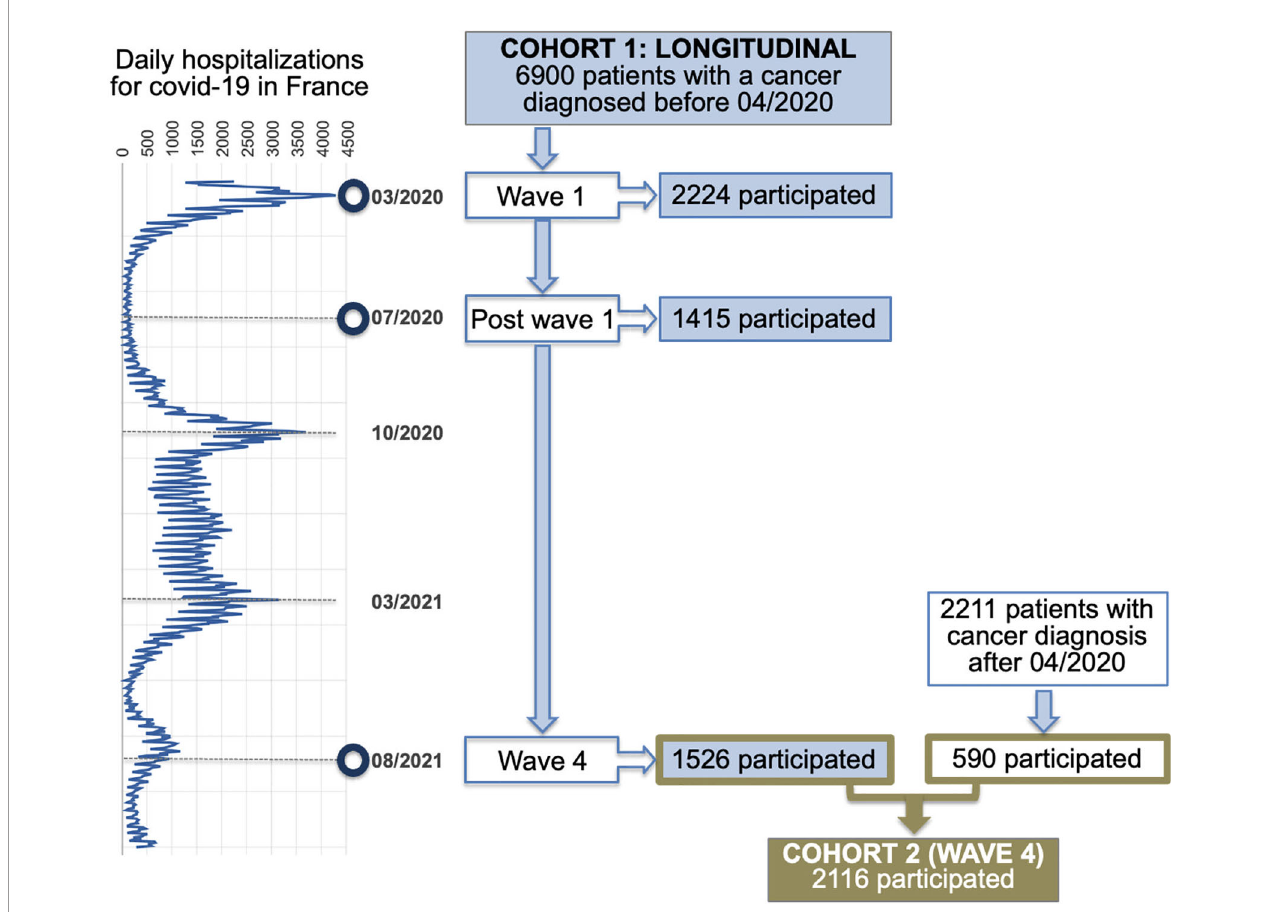
FIGURE 1 | Study fl ow diagram. Cohort 1 is the longitudinal part of the study where online questionnaires were administered at three time points during the pandemic in France: the fi rst wave, post wave 1, and wave 4. Cohort 2 gathered cancer patients from cohort 1 who completed the questionnaire at wave 4 and patients with newly diagnosed cancer during the pandemic (between May 2020 and July 2021). The left vignette shows the COVID-19 waves in France based on the curve of daily hospitalizations for COVID-19